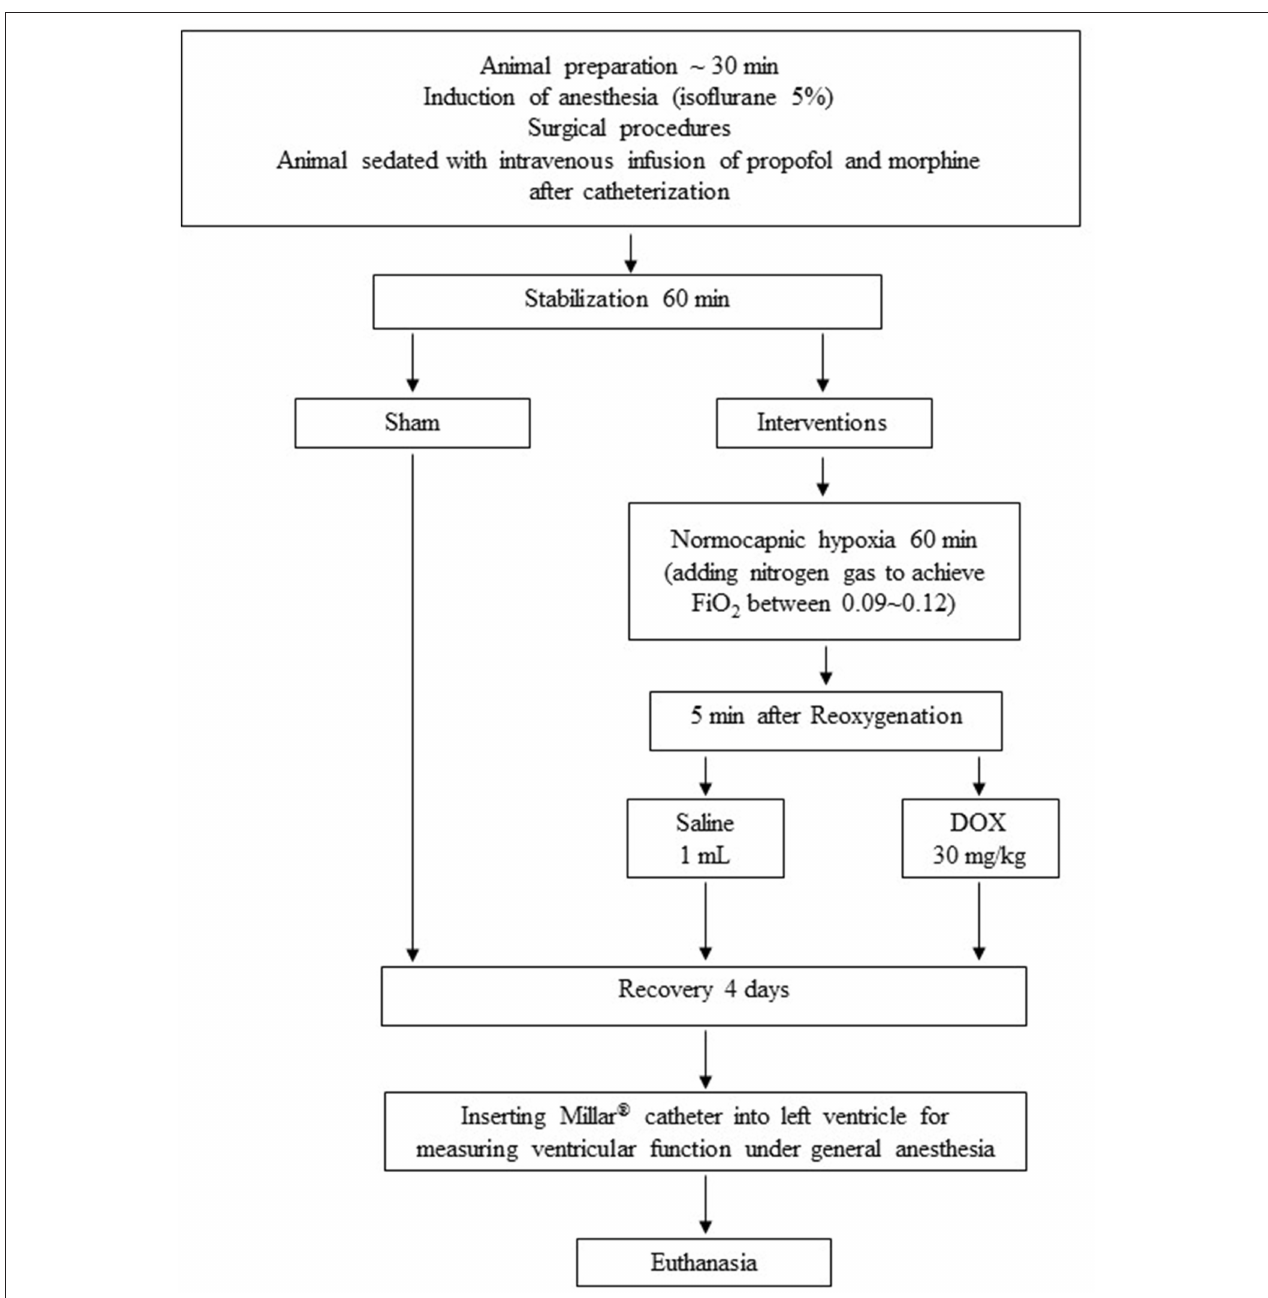
FIGURE 1 | Experimental